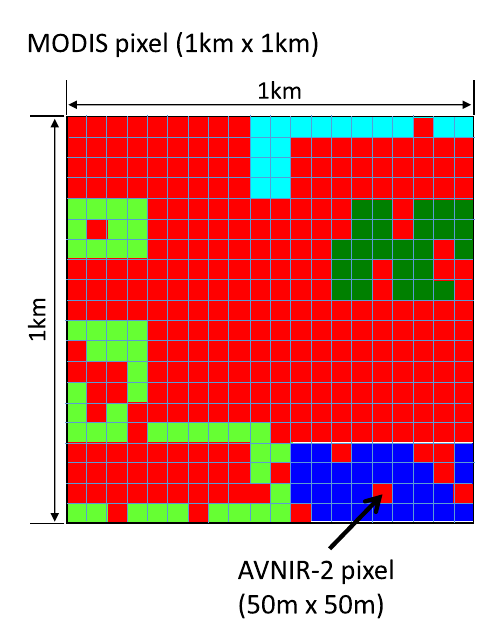
Figure 2. Schematic of the MODIS and AVNIR-2 pixel sizes. For example, the dominance of the land cover type shown in red for the MODIS pixel is calculated by dividing the number of the pixels in red ( = 285) by the number of all the pixels ( =